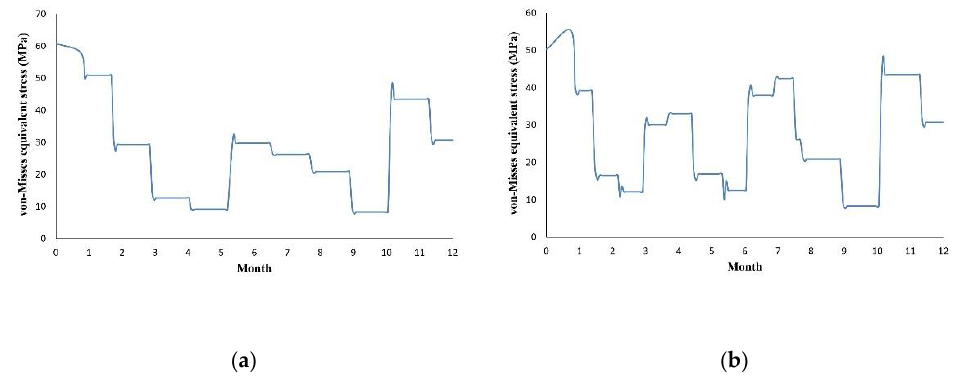
Figure 12. The von Mises equivalent stress history for both modes, including ( a ) small temperature variations and ( b ) large temperature variations.